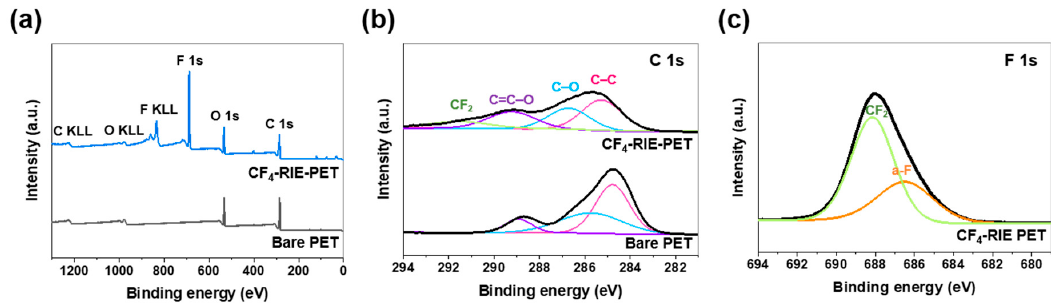
Figure 2. High-resolution XPS spectra of bare PET and CF 4 -RIE PET; ( a ) survey spectra, ( b ) C 1s core- level spectra, and ( c ) F 1s core-level spectra.